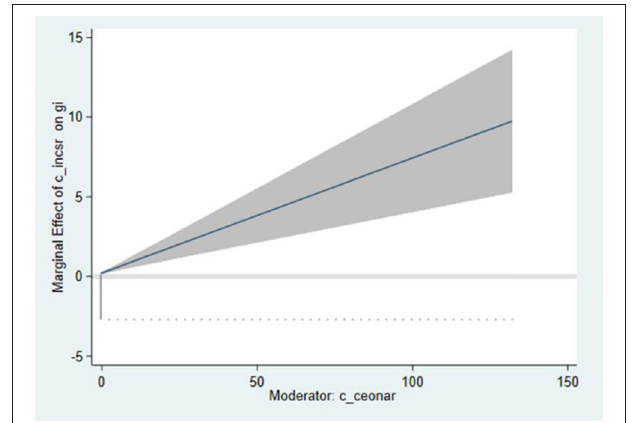
FIGURE 2 | Interaction between c_incsr and c_ceonar.